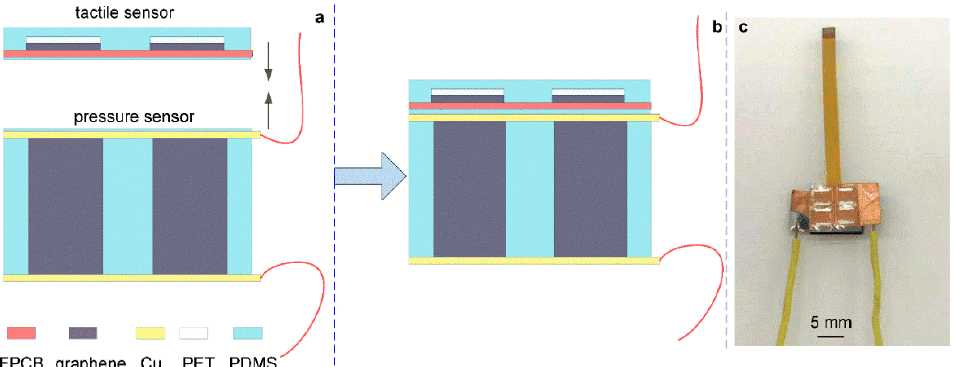
Figure 5. The flow chart and physical diagram of the assembling processes of the tactile-pressure sensor. ( a ) The assemble processes of the tactile-pressure sensor. ( b ) The schematic of the assembled tactile-pressure sensor. ( c ) The photo of the fabricated tactile-pressure sensor.